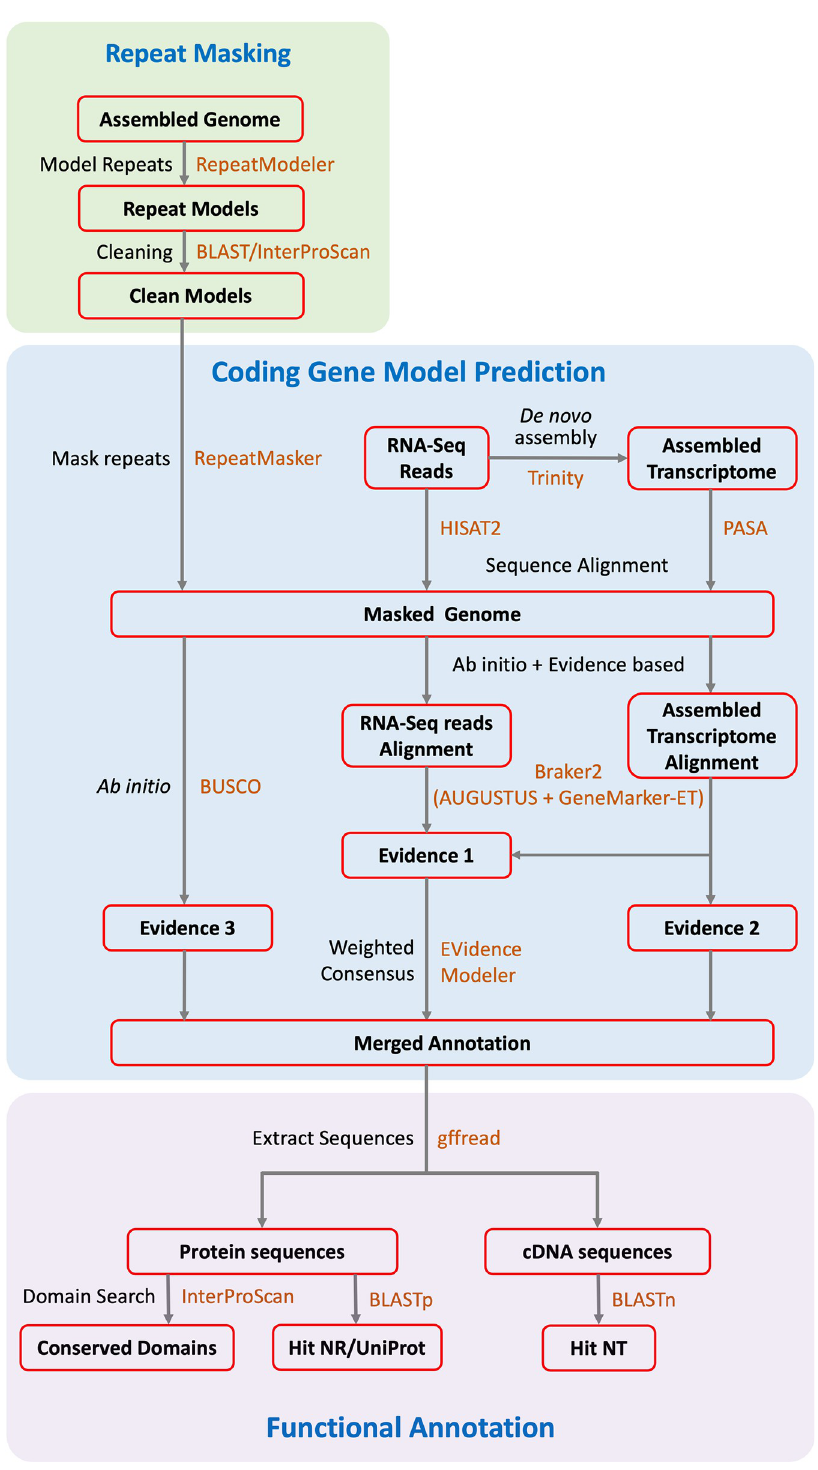
Fig 1. A typical eukaryote genome annotation workflow of protein coding gene annotation for the B . pfeifferi genome. The workflow contains three stages (boxes): repeat-masking (green), gene model prediction (blue) and functional annotation (purple). The intermediate and final results were labeled in boxes with red frames. The analytical processes were marked out in black-colored text and bioinformatics tools marked in orange-colored text.